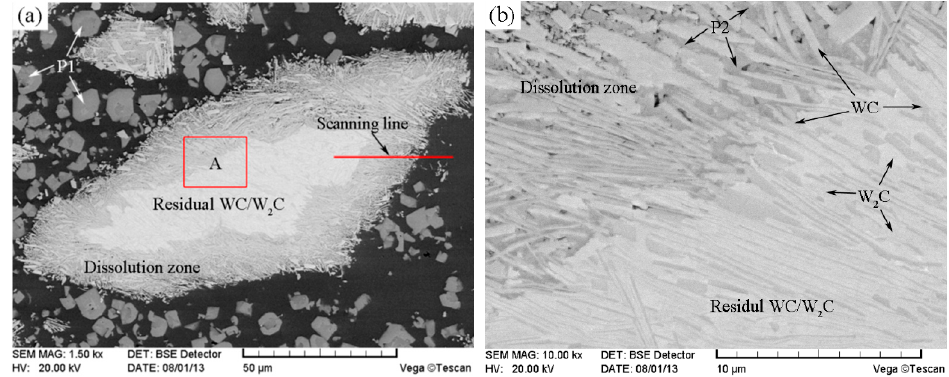
Figure 4. ( a ) SEM image of the unmodified CTC P -NiCrBSi, and ( b ) magnified SEM image of the zone “A” in ( a ).